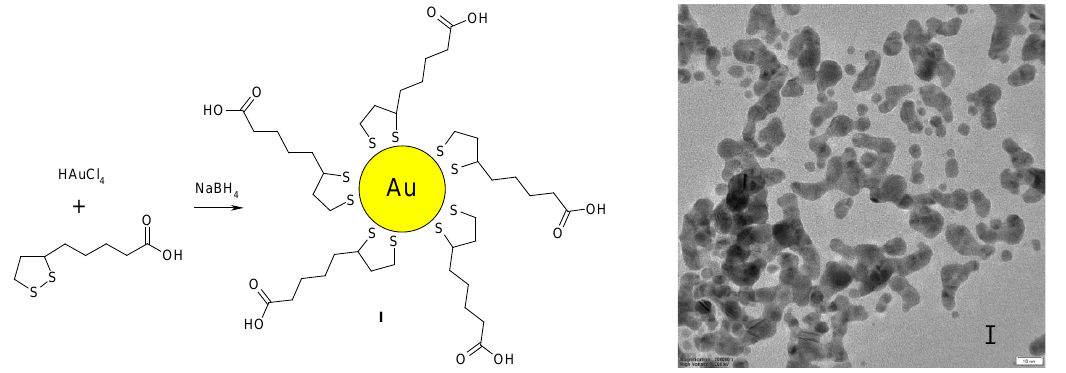
Figure 1. Synthesis of lipoic acid (LA) Au NPs ( left ) and their transmission electron microscopy (TEM) image ( right ). Scale bar 10 nm.